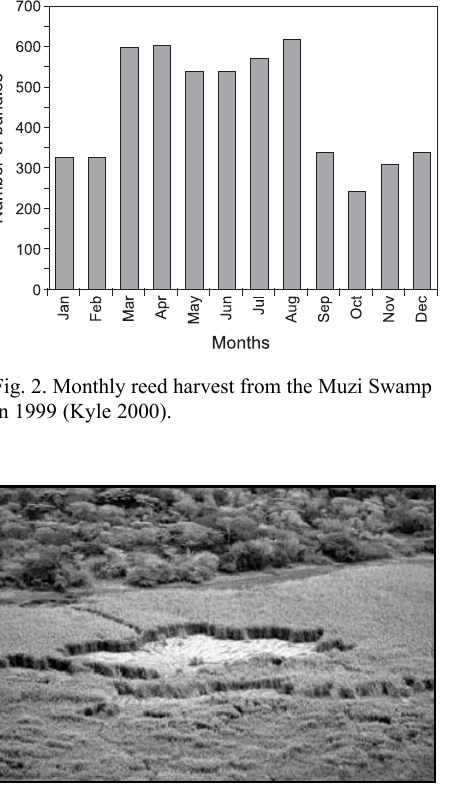
Fig. 3. Aerial view of a harvested area in the Muzi